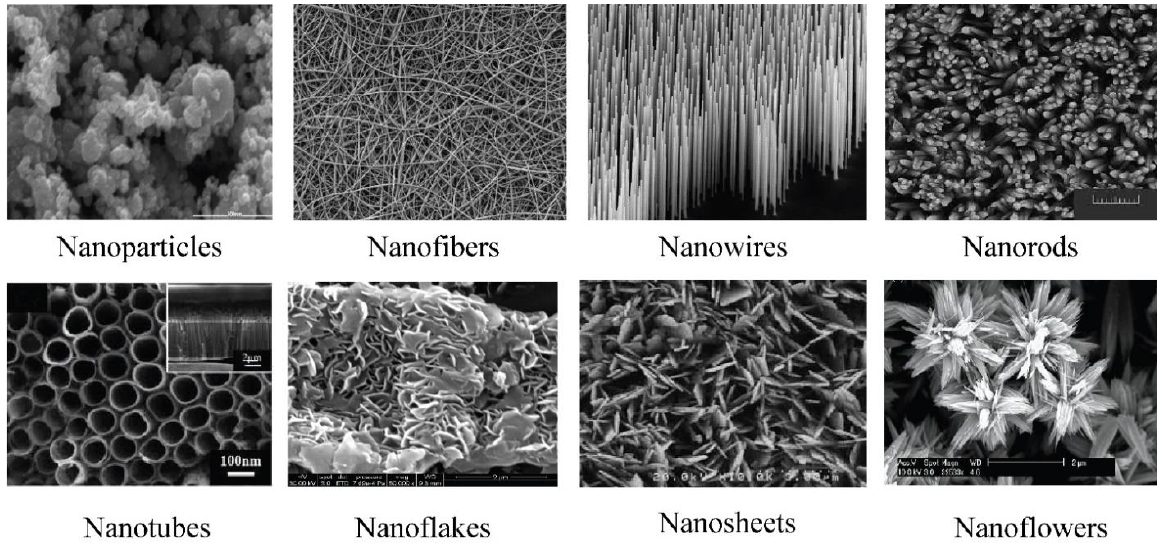
Figure 3. Different types of hierarchical nanostructures of TiO 2 .